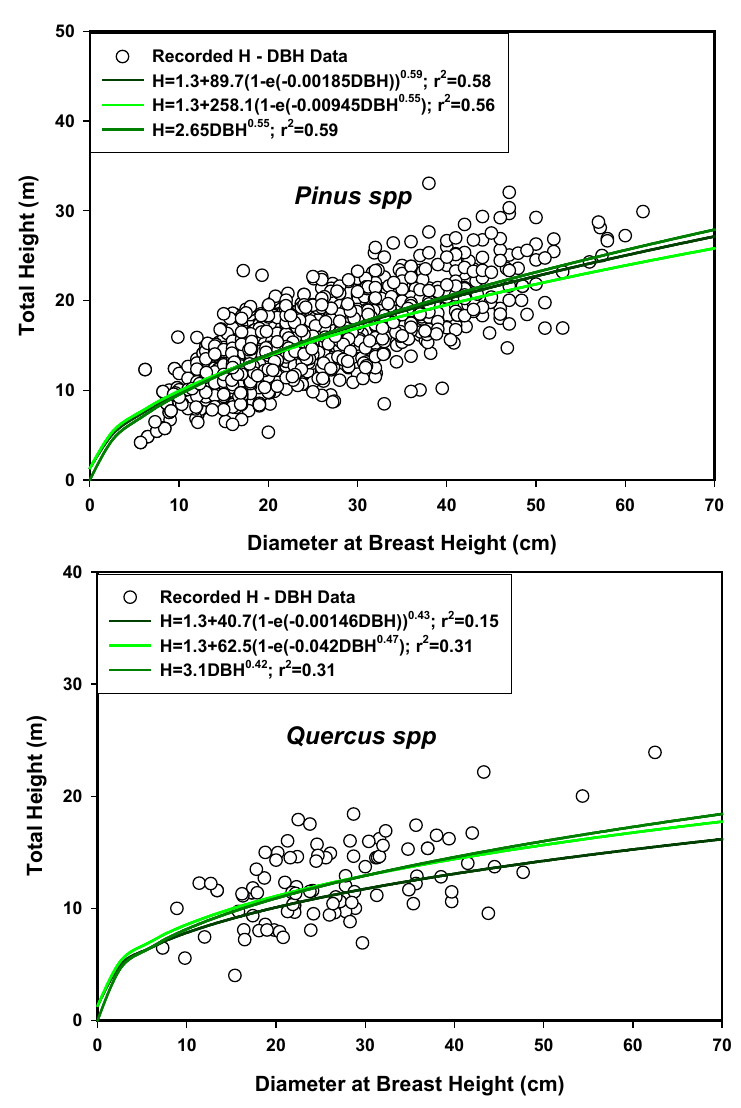
Figure 6. Three equations fitted to the total height—diameter at breast height relationship for pines and oaks of northern temperate forests of